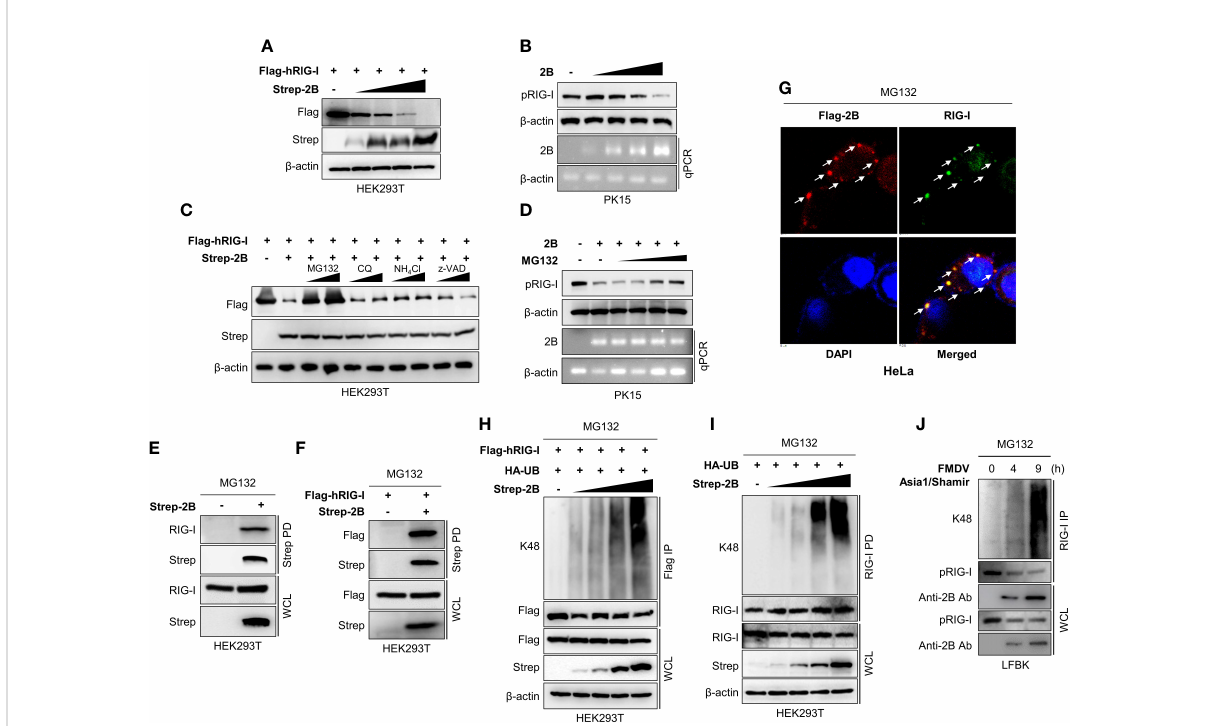
FIGURE 3 FMDV 2B targets RIG-I and mediates degradation of RIG-I via K48-linked polyubiquitination. HEK293T cells were transfected with Flag-hRIG-I plasmid, and increasing doses of Strep-FMDV 2B plasmids (A) , PK-15 cells were transfected with increasing amounts of FMDV 2B and 24 hrs post-transfection cells were infected with SeV [1 multiplicity of infection (MOI)] (B) . Cells were harvested at 24 hrs post-infection, and RIG-I expression level was measured by immunoblotting. HEK293T cells were transfected with Flag-hRIG-I together with Strep-FMDV 2B and treated with two doses of MG132, chloroquine, NH 4 Cl, or z-VAD for 6 hours before harvesting the cells. Whole-cell lysates were subjected to immunoblotting with indicated antibodies (C) . PK-15 cells were transfected with Strep-FMDV 2B, and 24 hrs post-transfection cells were infected with SeV (1MOI). Cells were treated with increasing doses of MG132 at 18 hours hrs post-infection and harvested at 24 hrs post- infection. The RIG-I expression level was measured by immunoblotting (D) . HEK293T cells were transfected with Strep-FMDV 2B (E) or Flag- RIG-I together with Strep-FMDV 2B (F) and treated with MG132 for 6 hours before harvesting the cells. Cell lysates were subjected to Strep pull- down and immunoblotted with the indicated antibodies. HeLa cells were transfected with Flag-FMDV 2B and treated with MG132 for 6 hours before fi xing the plate, followed by confocal microscopy with anti-Flag (red) and anti-RIG-I (green) antibodies. Nuclei were stained with DAPI (blue) (G) . HEK293T cells were transfected with Flag-RIG-I, HA-ubiquitin together with increasing doses of Strep-FMDV 2B plasmids and treated with MG132 for 6 hours before harvesting the cells. Whole-cell lysates were subjected to Flag immunoprecipitation and immunoblotted with indicated antibodies (H) . HEK293T cells were transfected with HA-ubiquitin together with increasing doses of Strep-2B plasmids and treated with MG132 for 6 hours before harvesting the cells. Whole-cell lysates were subjected to immunoprecipitation with RIG-I antibody and immunoblotted with indicated antibodies (I) . LFBK cells were infected with FMDV Asia1/Shamir strain and treated with MG132 for 6 hours before harvesting the cells. Cells were harvested at indicated time after infection and whole-cell lysates were immunoprecipitated with anti-RIG-I antibody and immunoblotted with indicated antibodies (J) . Results representative of at least two independent experiments, each with similar results. (pRIG-I: porcine RIG-I, hRIG-I: human